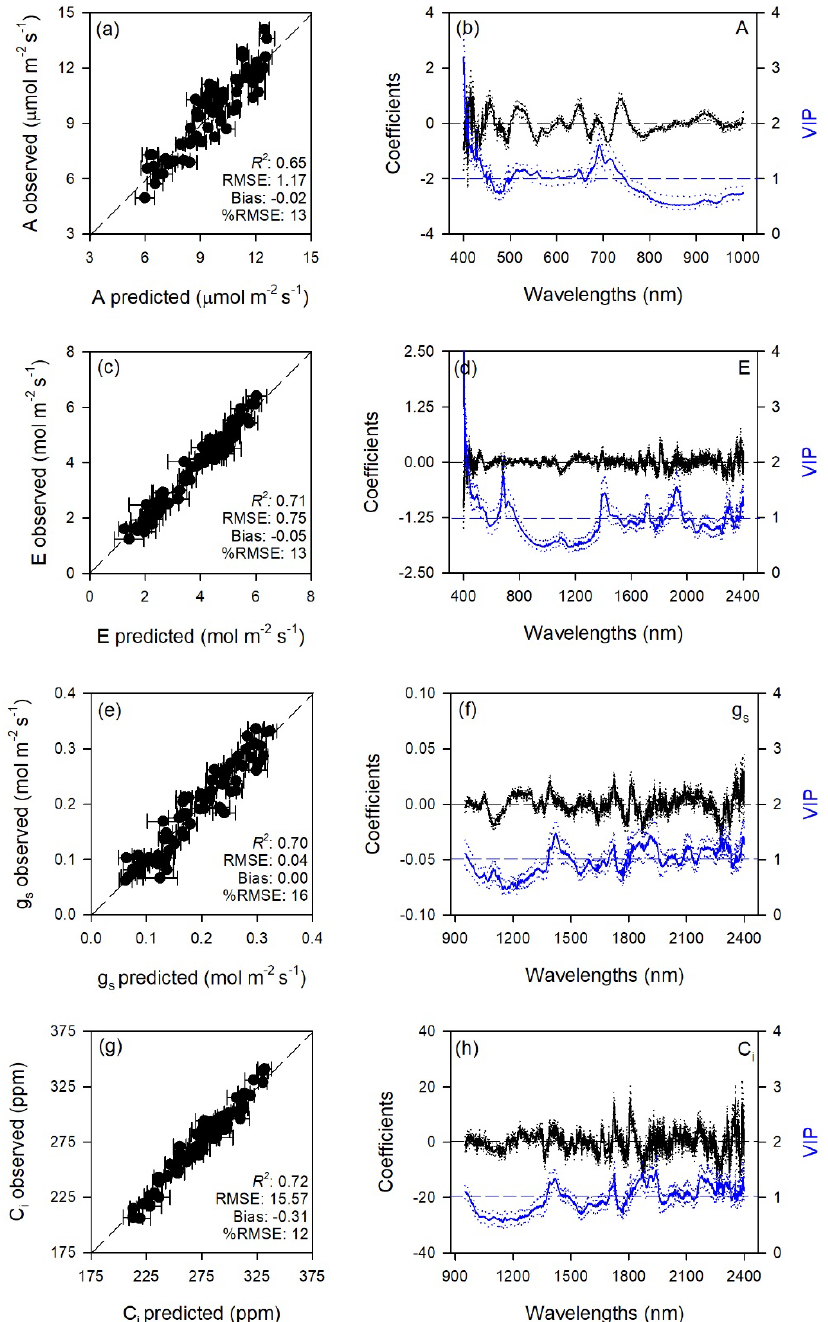
Figure 1. ( a , c , e , g ) Observed versus partial least squares regression (PLSR)-predicted values of CO 2 assimilation rate (A), transpiration (E), stomatal conductance (g s ), and intercellular CO 2 concentration (C i ) in sage; error bars for predicted values represent the standard deviations generated from 500 simulated models; dashed line is 1:1 relationship; model goodness-of-fit ( R 2 ), root mean square error (RMSE), bias and %RMSE for validation data generated using 80% of the data for calibration and 20% for validation are reported. ( b , d , f , h ) Mean (solid), 5th and 95th percentile (dotted) of standardized coefficients (black), and variable importance for projection values (VIP, blue) by wavelengths for PLSR-models predicting A, E, g s , and C i in sage.